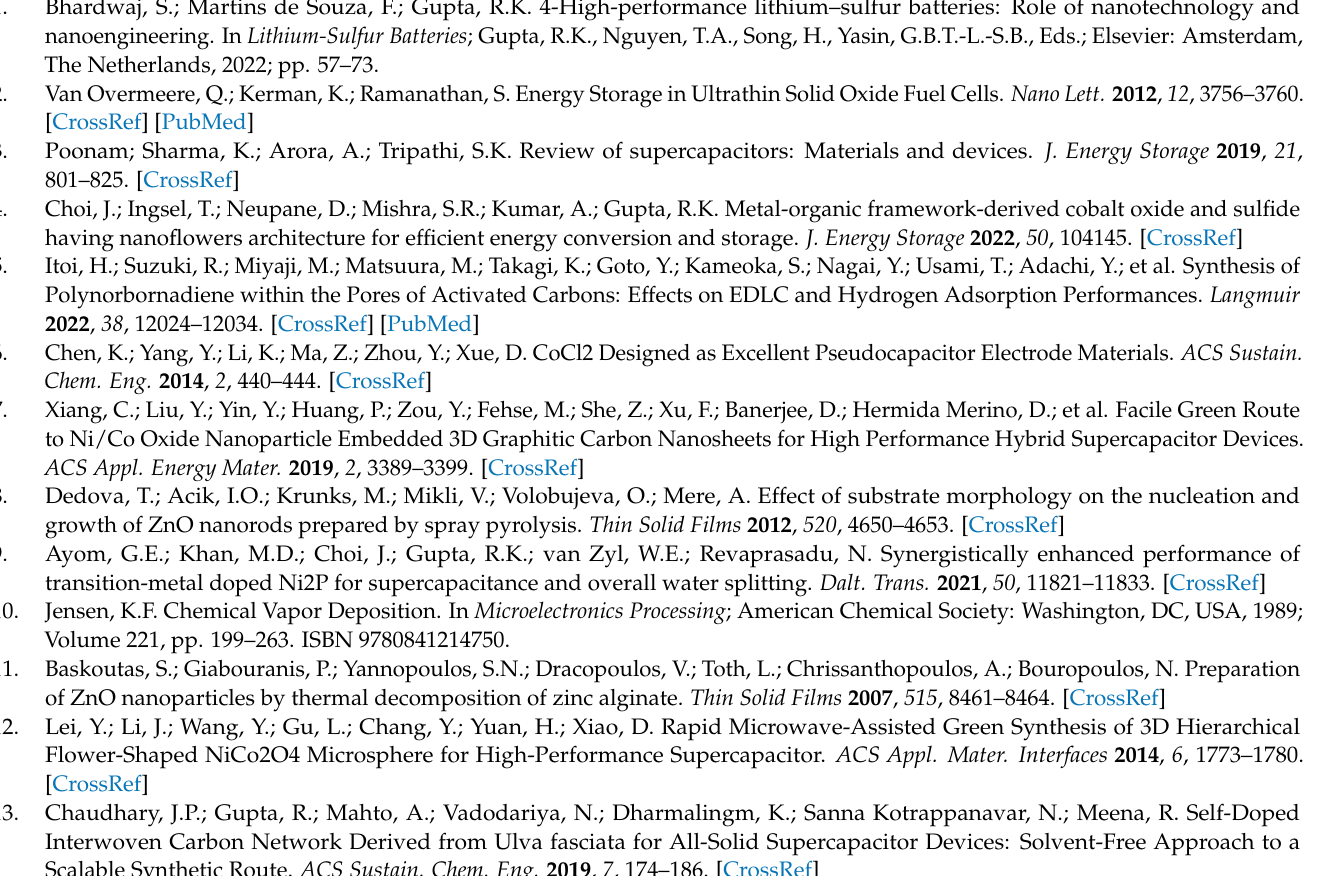
Table S1: The comparison between specific capacitance (Csp), power density, and energy density of the synthesized